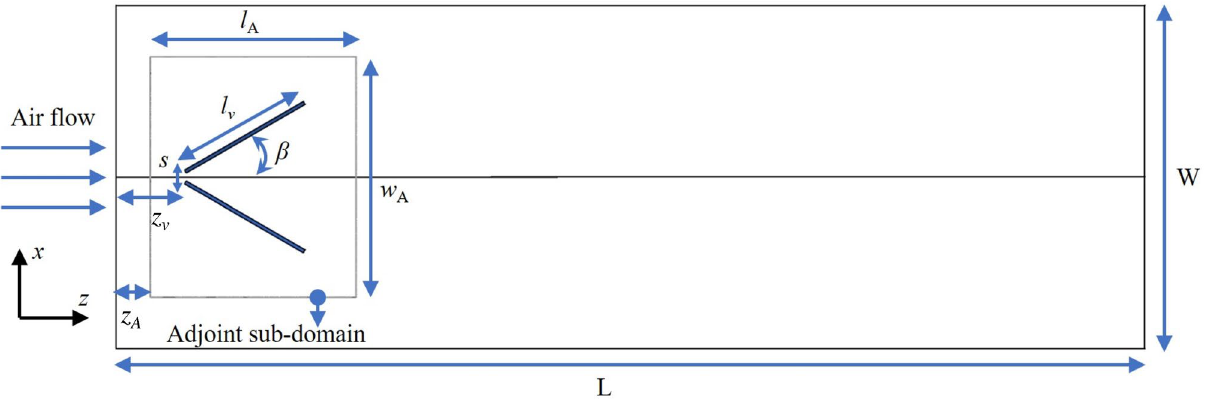
Figure 8. The geometry of the rectangular channel with delta-delta winglet pair. The adjoint shape optimization problem is solved in the adjoint sub-domain. Dimensions of the channel are h = 20 mm , W = 5 h and L = 15 h . The RVG has s = 0.2 h , z v = h and β = 30 ◦ . The adjoint sub-domain has a control volume (cid:31) v = I A × w A × h with the following dimensions: I A = 7 h / 2 , w A = 7 h / 4 . It is positioned at z A = h / 2 away from the inlet enveloping the RVG to be